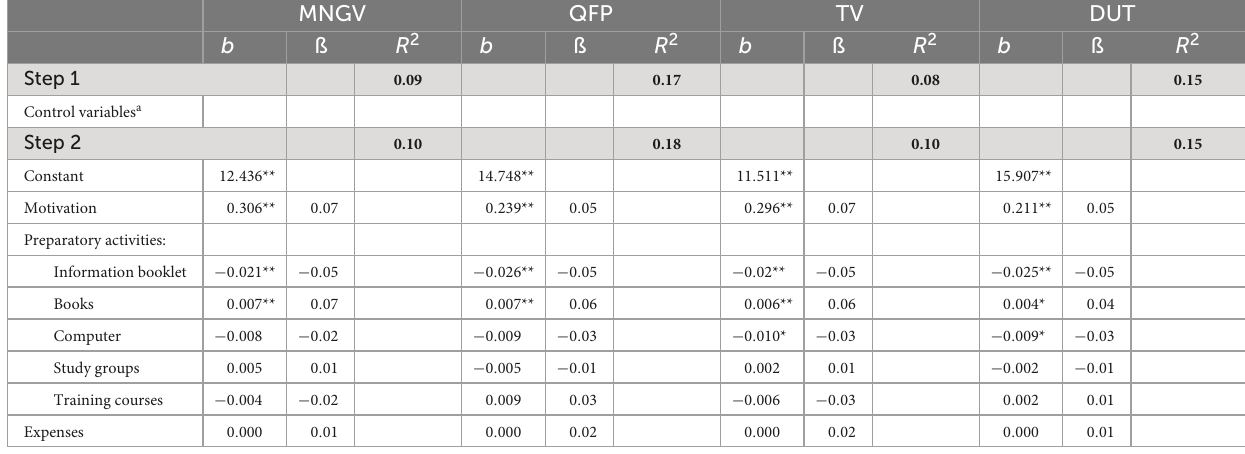
TABLE 7 Hierarchical univariate multiple regression analyses predicting the complex TMS-subtests. MNGV QFP